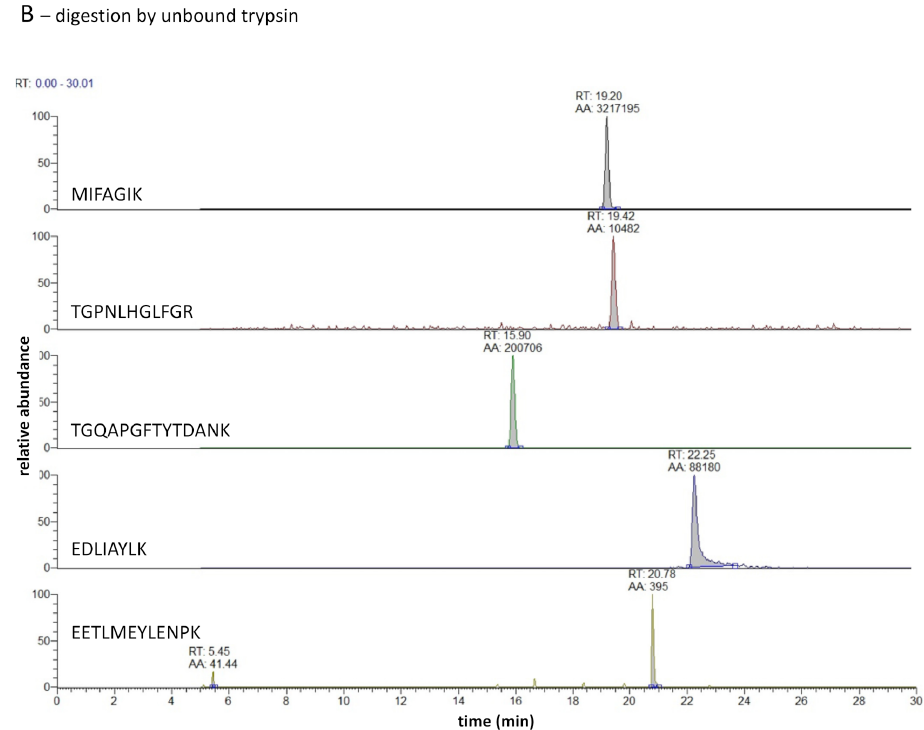
Figure 5. Ion chromatograms of five “zero missed-cleaved” peptides of Cytochrome C. m/z values of the traces measured are shown in Table 1. ( A ) A total of 10 µ L 25 µ g/mL CytC applied on a dry KIO 4 -functionalized trypsin disc which was washed three times with 2 mL 10 mM HCl followed by 2 mL water and concluded with a 100 µ L 50 mM ABC extraction. The disc was kept in a sealed container for 1 h. After the seal was taken off, the discs were left to air dry (1 h,) followed by extraction in 110 µ L 0.1% formic acid. ( B ) A total of 10 µ L 25 µ g/mL CytC added to the 100 µ L 50 mM ABC extract of a washed KIO 4 -functionalized trypsin disc. Incubation 2 h, reaction stopped with 10 µ L 1% FA. Both ( A ) and ( B ) were carried out at room